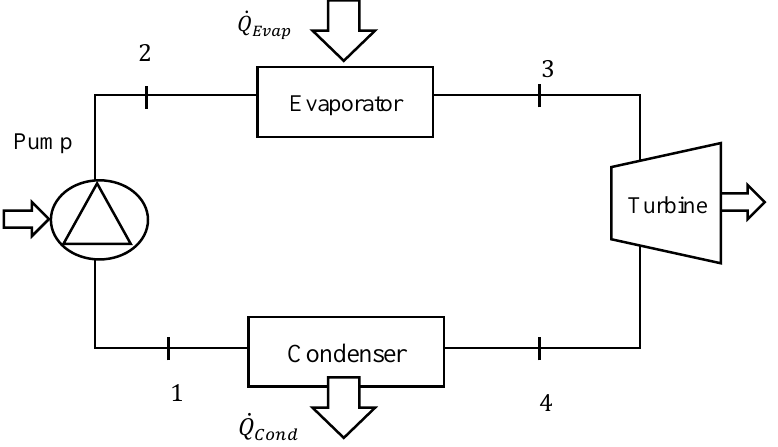
Figure 1. Scheme of Organic Rankine Cycle